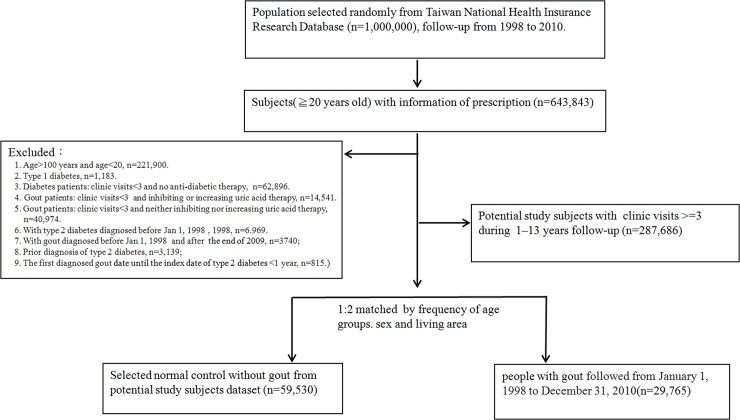
Schematic of the samples selection process for association between urate-lowering therapy and risk of type 2 diabetes mellitus.